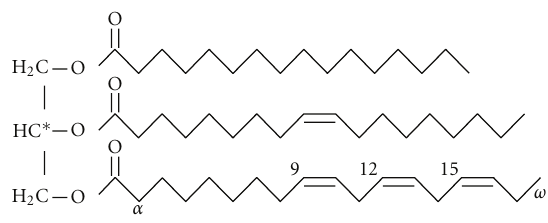
Figure 3: Triglyceride (TAG) C55H98O6 [11] see also Zamora [12].